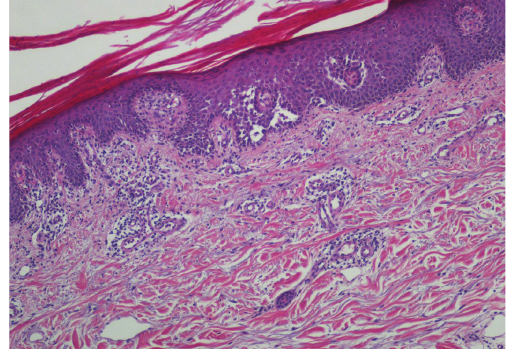
Figure 2: Skin biopsy showing foci of acantholytic dermatosis and loose perivascular lymphoid infiltrate in the superficial dermis (H&E 100x).